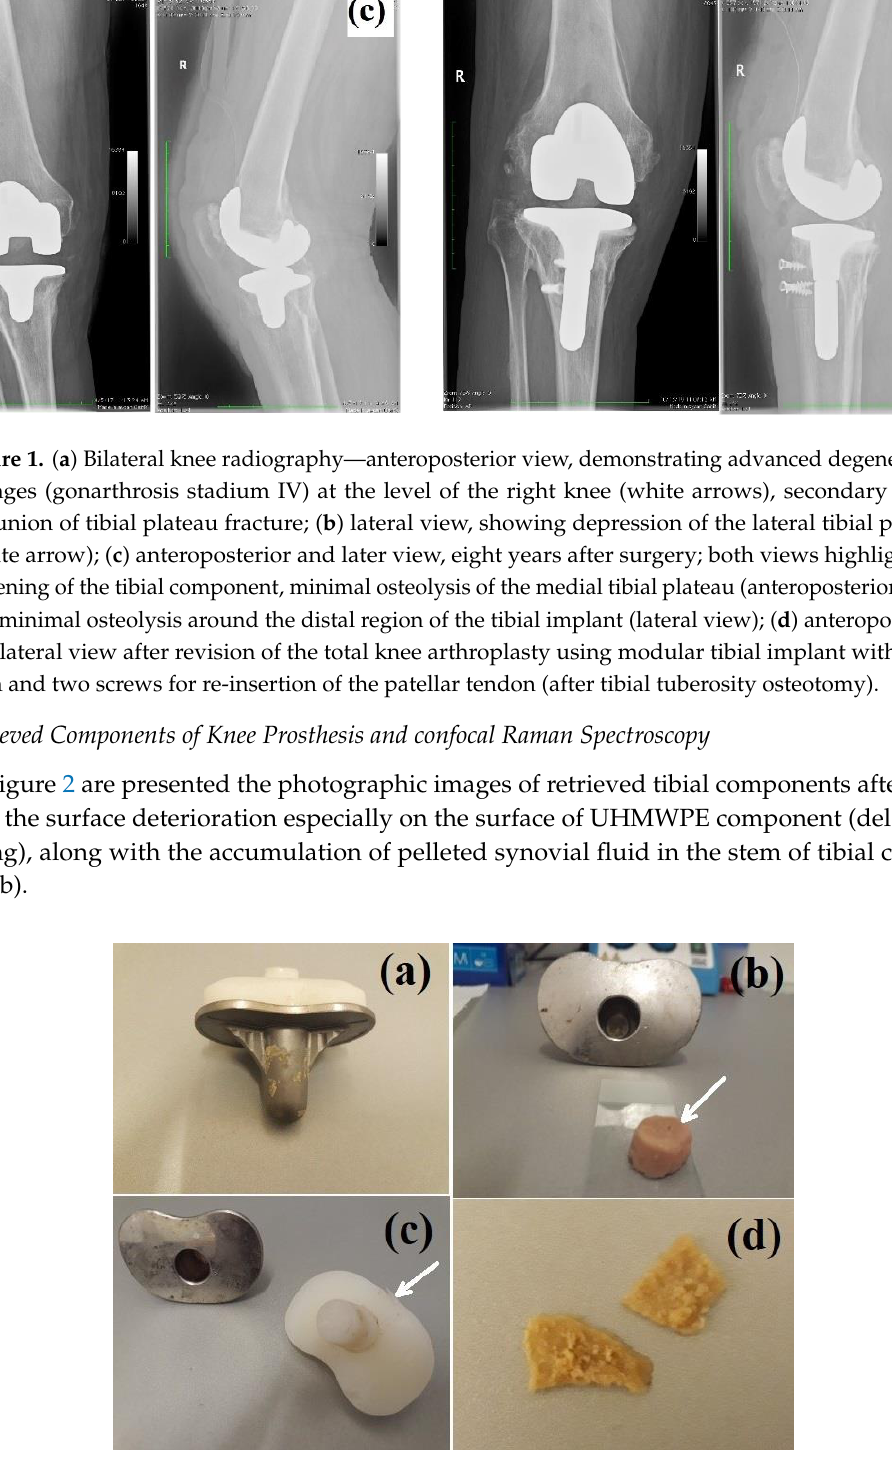
Figure 2. Photographic images of retrieved tibial components of knee prosthesis. ( a ) Assembled tibial components; ( b ) titanium component and synovial fluid collected from the stem (white arrow); ( c ) separate metallic and ultra-high-molecular-weight polyethylene (UHMWPE) component, showing surface delamination (white arrow); ( d ) acrylic cement detached from the metallic component.